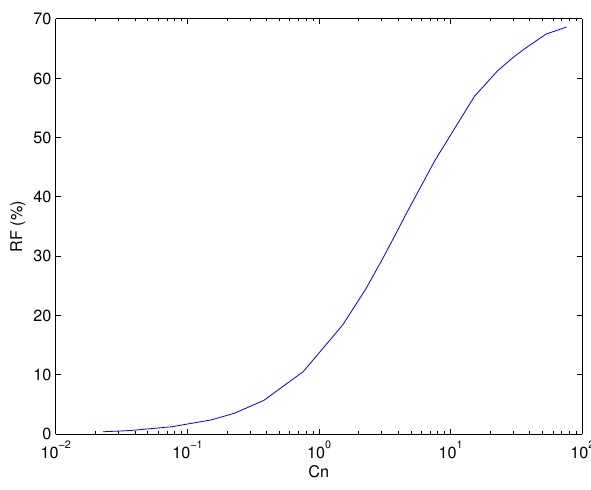
Fig. 7. Maximum re-condensation fraction as a function of C n